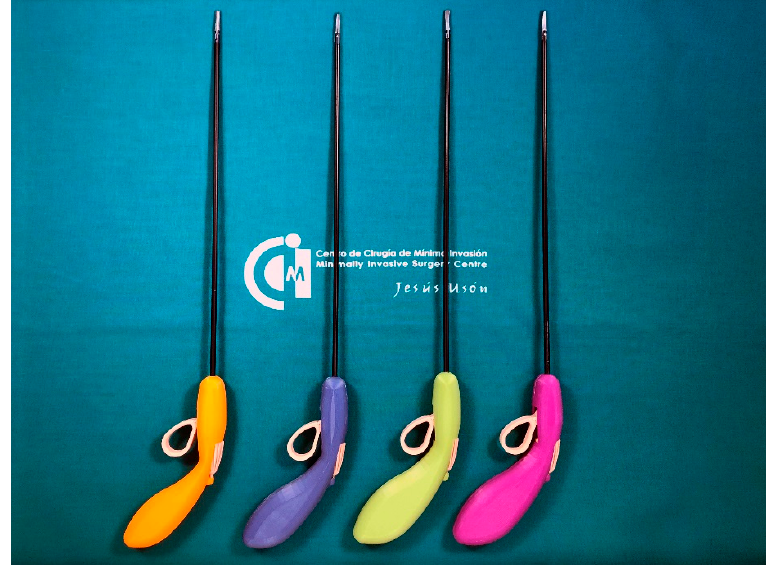
Figure 2. Prototypes of the handles for laparoscopic instruments developed. The sizes of the handles, from left to right, are XS, S, M and L.